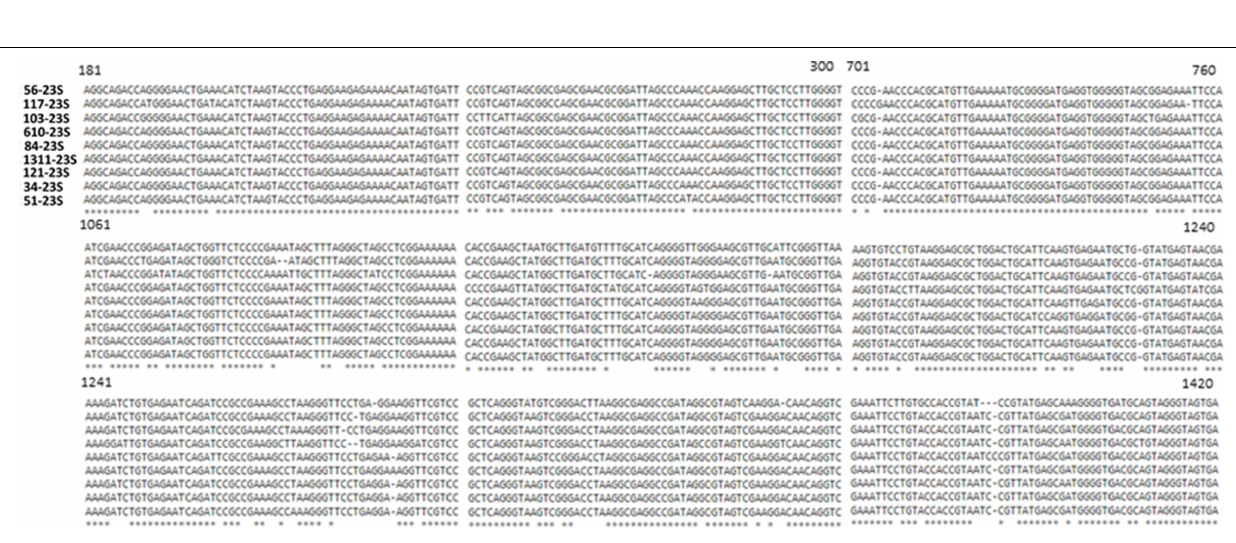
the nucleotide sequence data represent the position of each 60 nt frame. Regions not shown in the figure correspond to stretches of identical nucleotides between the depicted